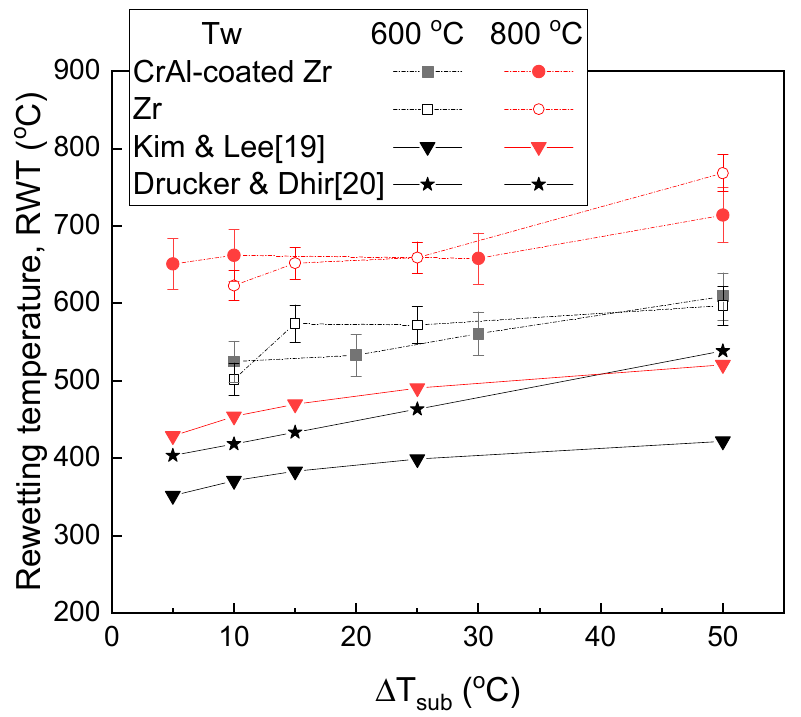
Figure 16. Comparison of rewetting temperature for Zr and CrAl-coated Zr claddings. The RWT correlations used in this study are those of Kim and Lee [19], and Drucker and Dhir [20]. Kim and Lee [19] proposed the prediction correlation of apparent rewetting temperature ( (cid:1846) (cid:3002)(cid:3019) ) in Equation (1) under the bottom flooding conditions of vertical circular tubes: